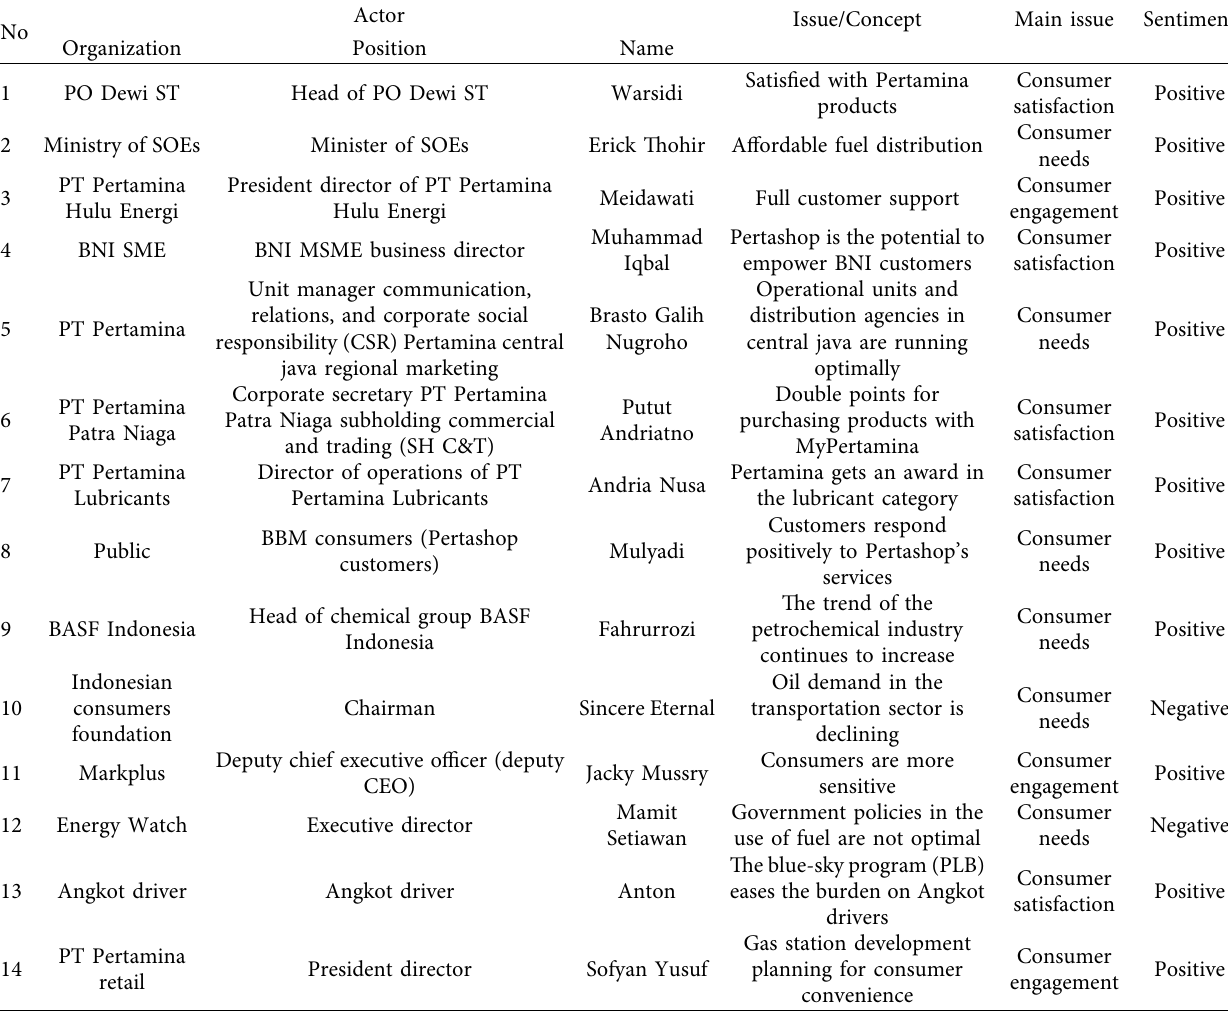
Table 1: Mapping of actors, issues, and sentiments about PT Pertamina’s consumer service segmentation. No